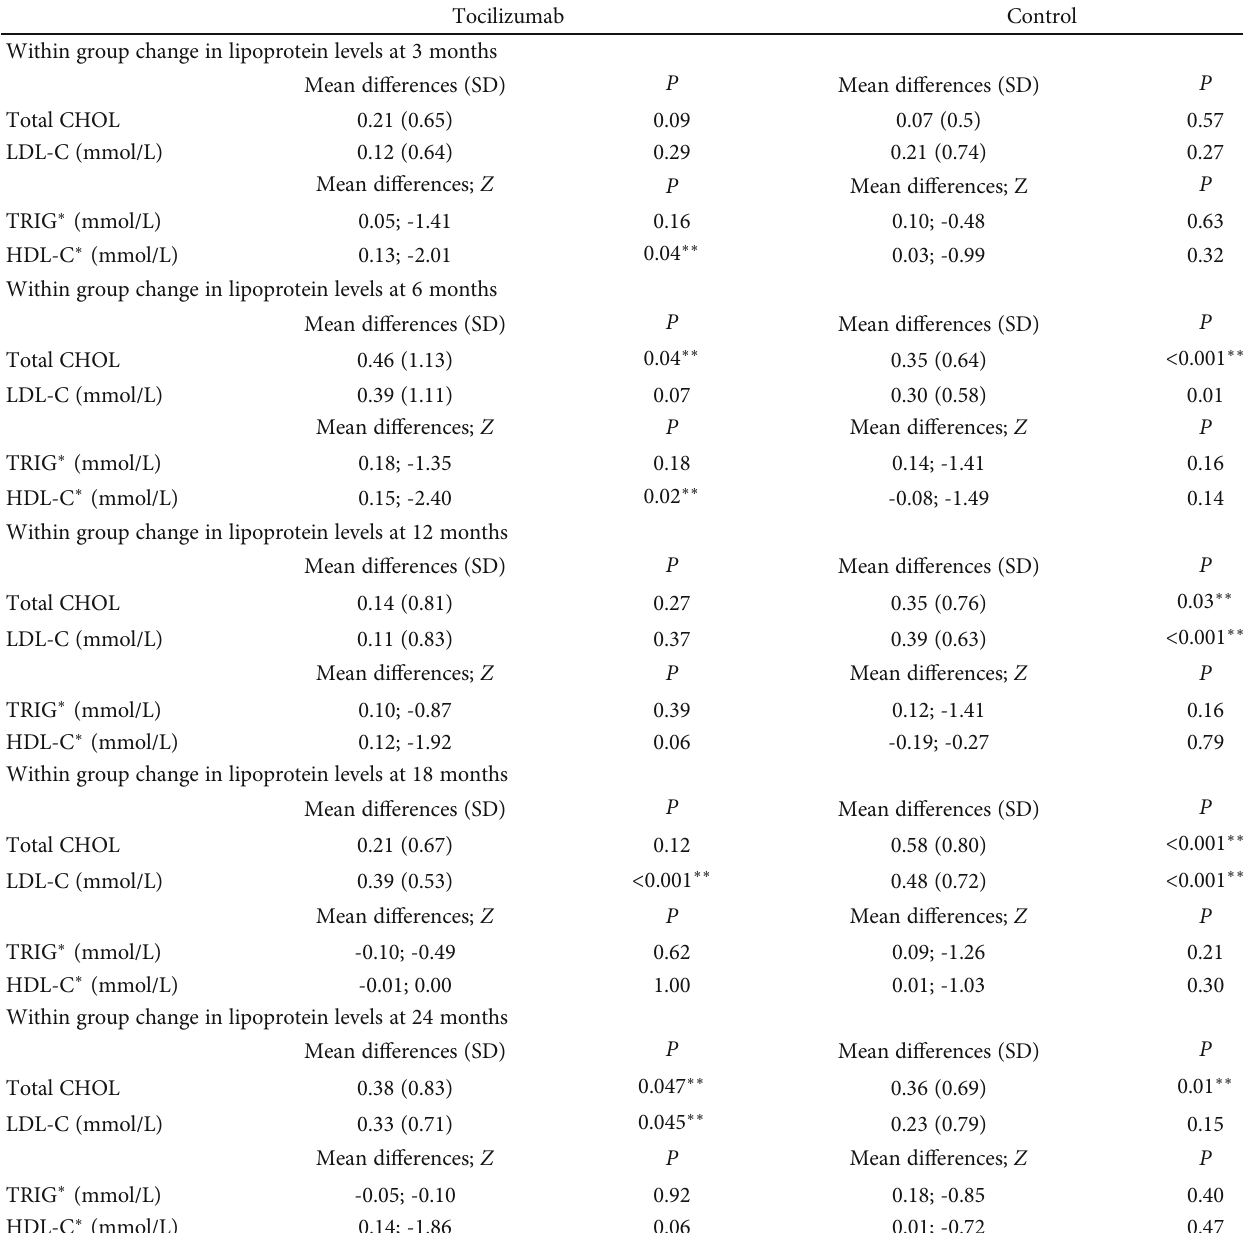
Table 5: Lipoprotein level changes at an indicated time